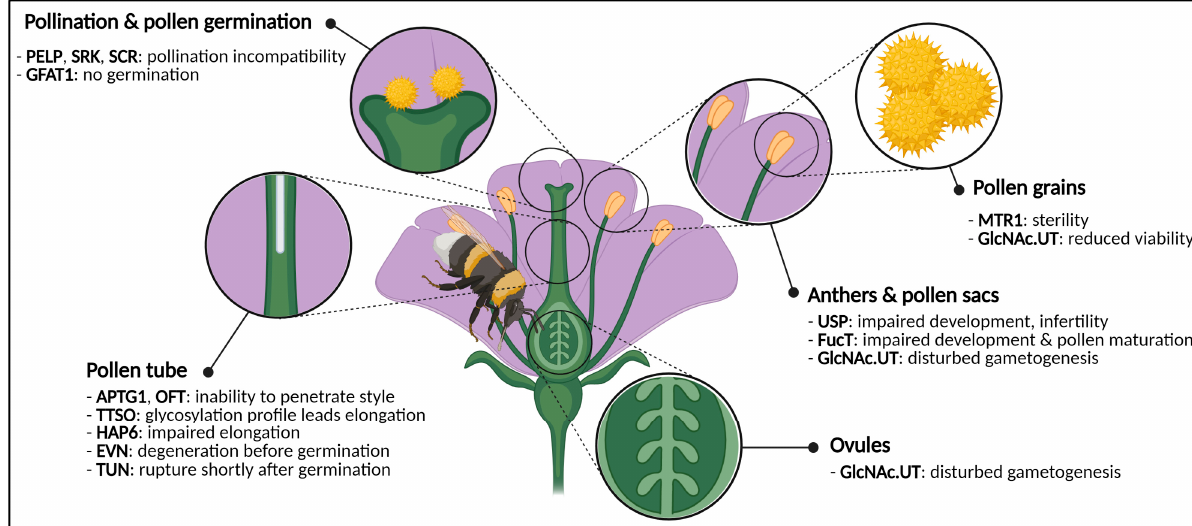
Figure 3. Graphical representation of a generic flower and phenotypes caused by impaired activity of glycosylation enzymes or glycoproteins. Disturbances cause phenotypes in both male and female gametes, anthers, pollen and pollen sacs, pollen germination and pollen tube elongation. Abbreviations: APTG1 (ABNORMAL POLLEN TUBE GUIDANCE1), EVN (EVAN), FucT ( α -1,3-fucosyltransferase), GFAT1 (glutamine:fructose-6-phosphate amidotransferase), GlcNAc.UT (GlcNAc-phosphate UDP-transferase), HAP6 (HAPLESS6), MTR1 (MICROSPORE AND TAPETUM REGULATOR1), OFT (O-fucosyltransferase), PELP (Pistil-Specific Extensin-Like Proteins), SCR (S-locus Cysteine Rich), SRK (S-locus Receptor Kinase), TTSO (Transmitting Tissue Specific O-glycoprotein), TUN (TURAN), USP (UDP-sugar pyrophosphorylase). This figure was created with